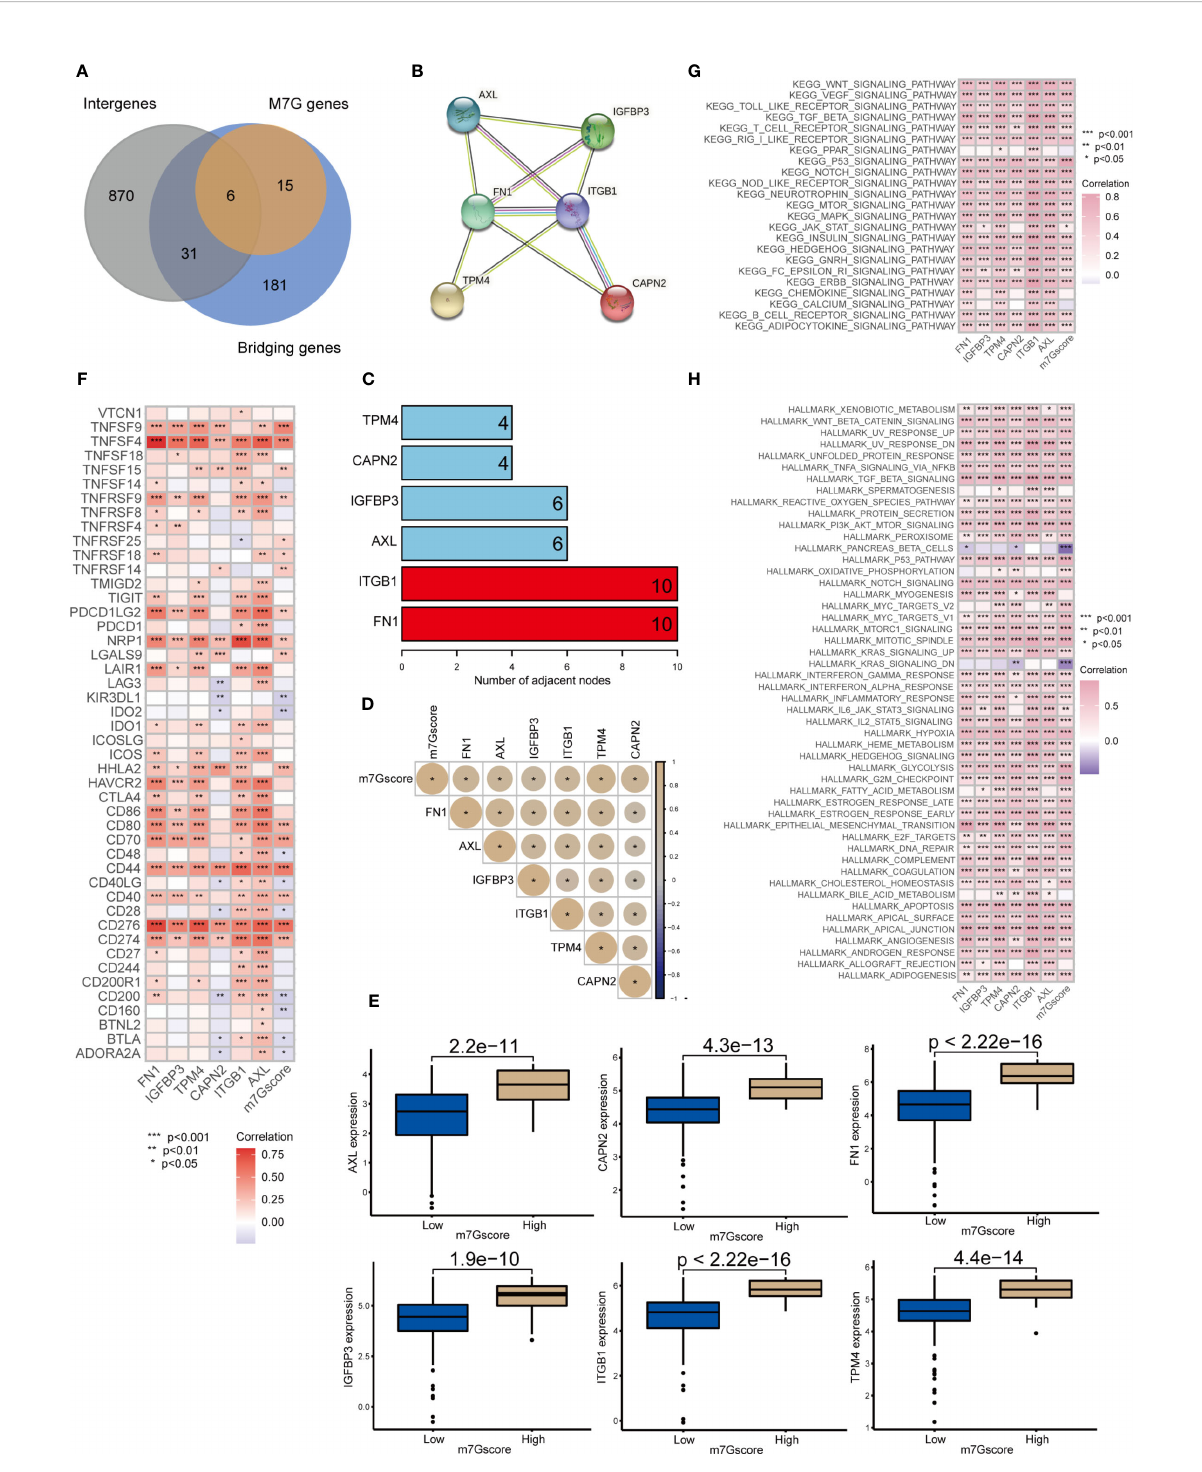
FIGURE 6 Network of m7G target genes in the m7G score model *p<0.05; **p<0.01; ***p<0.001. (A) Venn diagram of cluster intergenes, bridging genes and m7G target genes. (B) Core genes of the PPI network of m7G methylation genes. (C) PPI network of the m7G methylation genes. (D) Correlation analysis of m7Gscore and m7G target gene. (E) Expression of m7G target genes in high and low m7G groups. (F) Correlation analysis of m7G target genes and m7G score with immune checkpoint related genes. (G, H) GSVA analysis of m7G target genes and